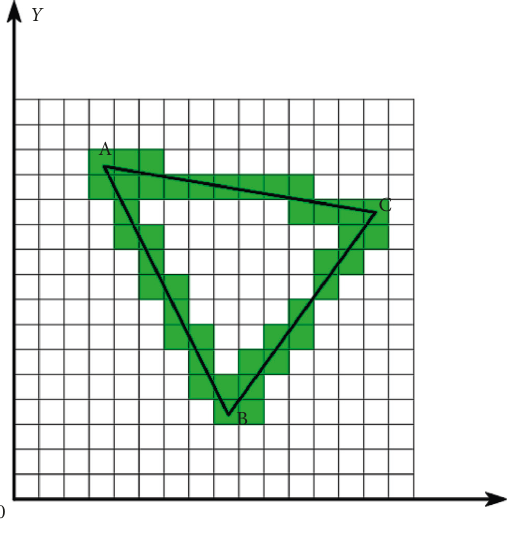
Figure 7: Meshing boundary lines.